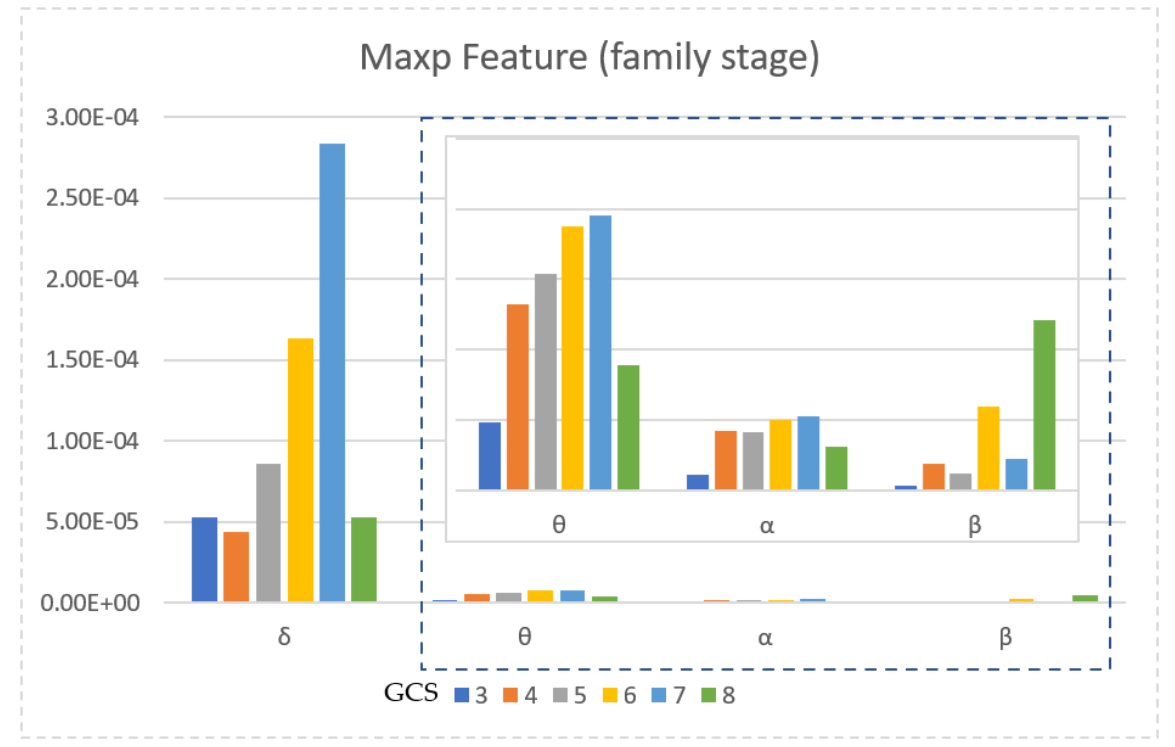
Figure 9. Mean of power values for all channels relative to sub-bands.